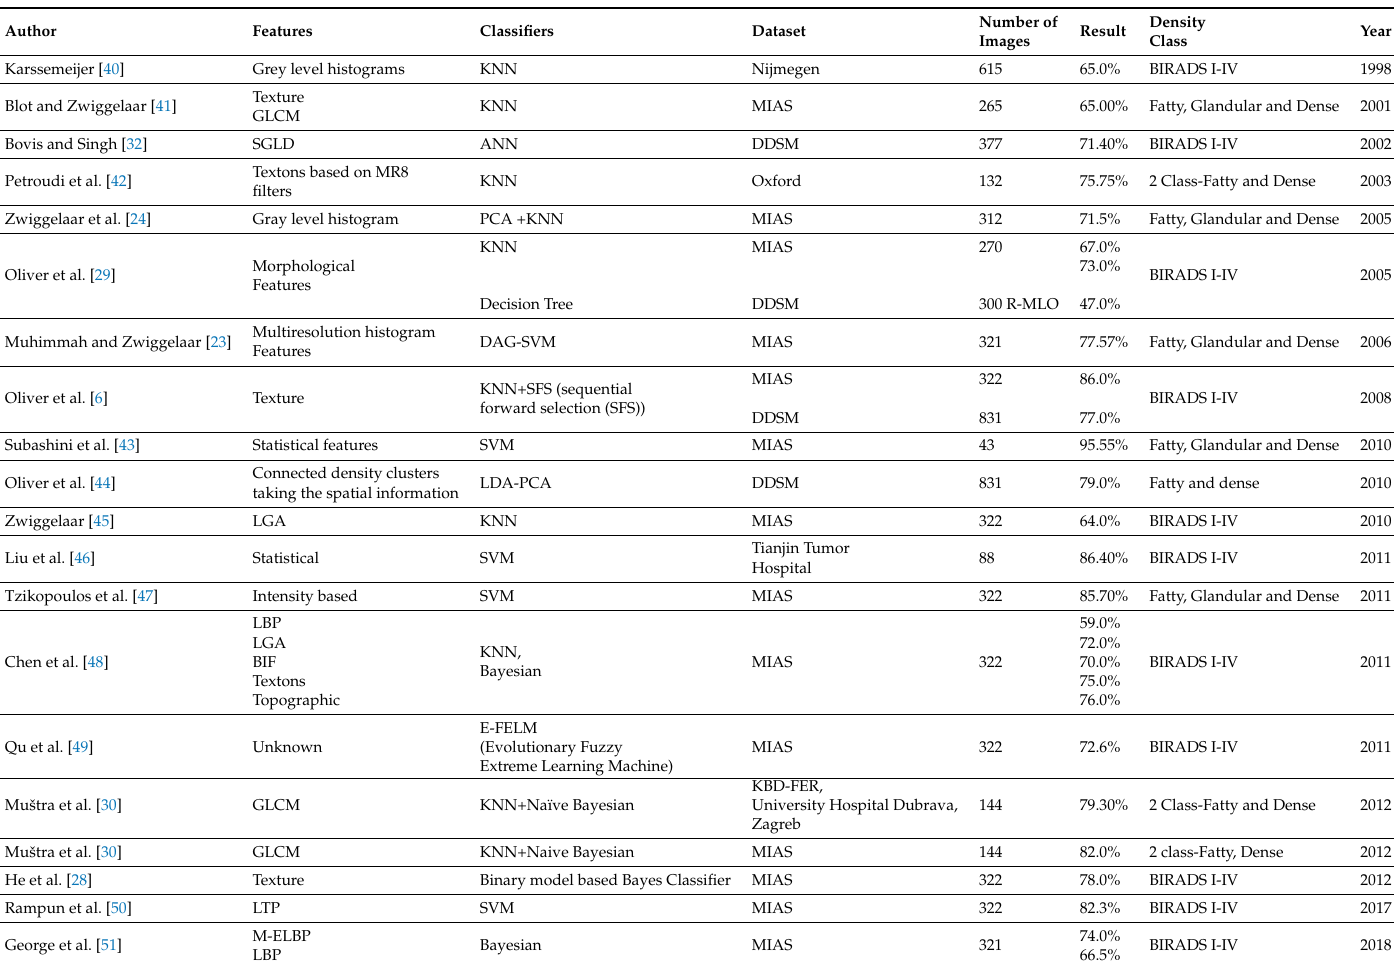
Table 1. A summary of existing approaches on breast density classification indicating authors, years of publication, techniques, experimental data for test, and